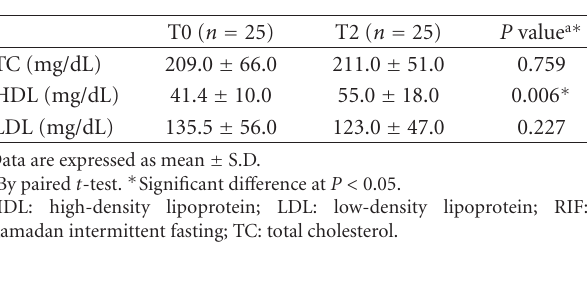
Table 4: Variation in lipid profile before and after